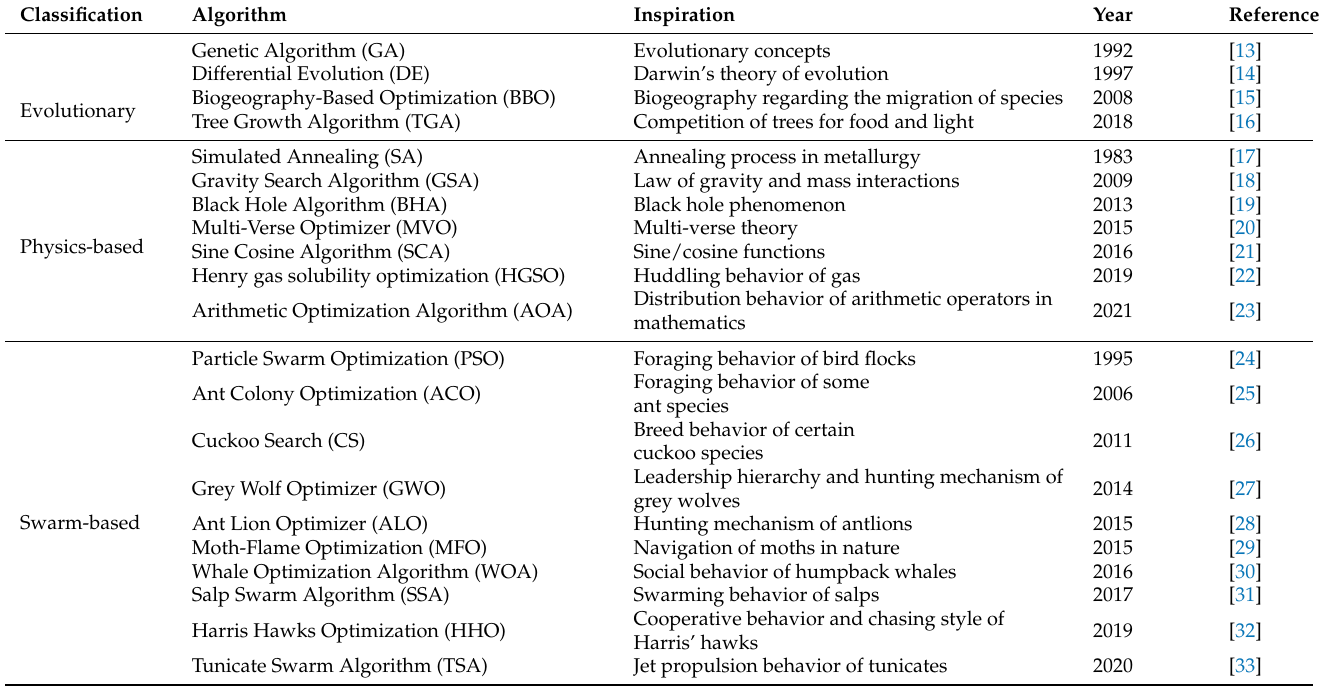
Table 1. Classification of meta-heuristic